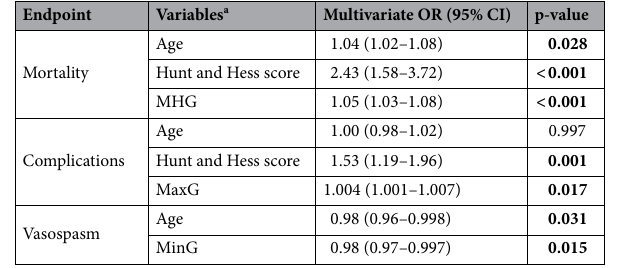
Table 4. Multivariate analysis of primary endpoints. Boldface values are statistically significant. a Only variables included in final models are